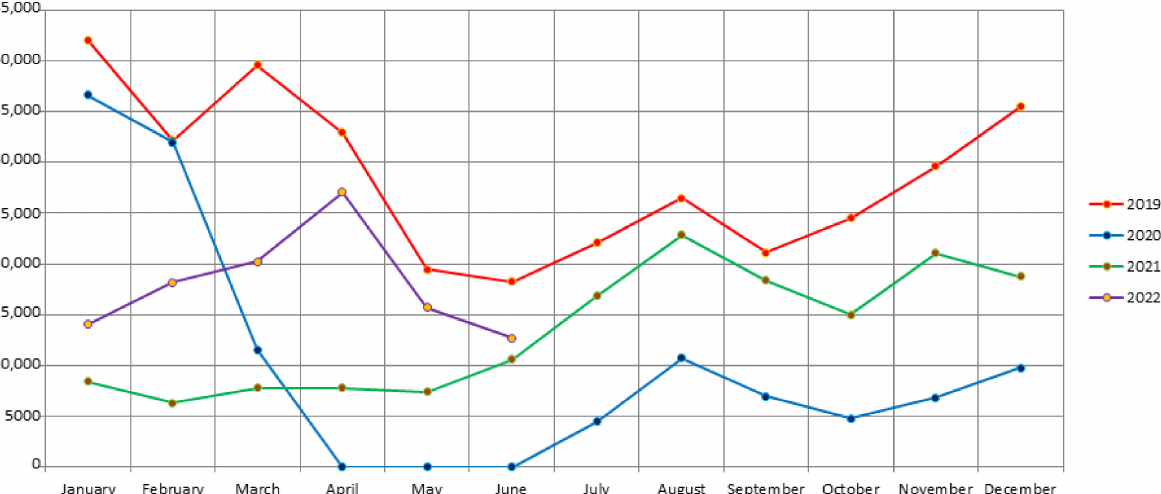
Figure 3. Tourist visitors (number) to the island of La Palma (Canary Islands, Spain). Source: ISTAC.